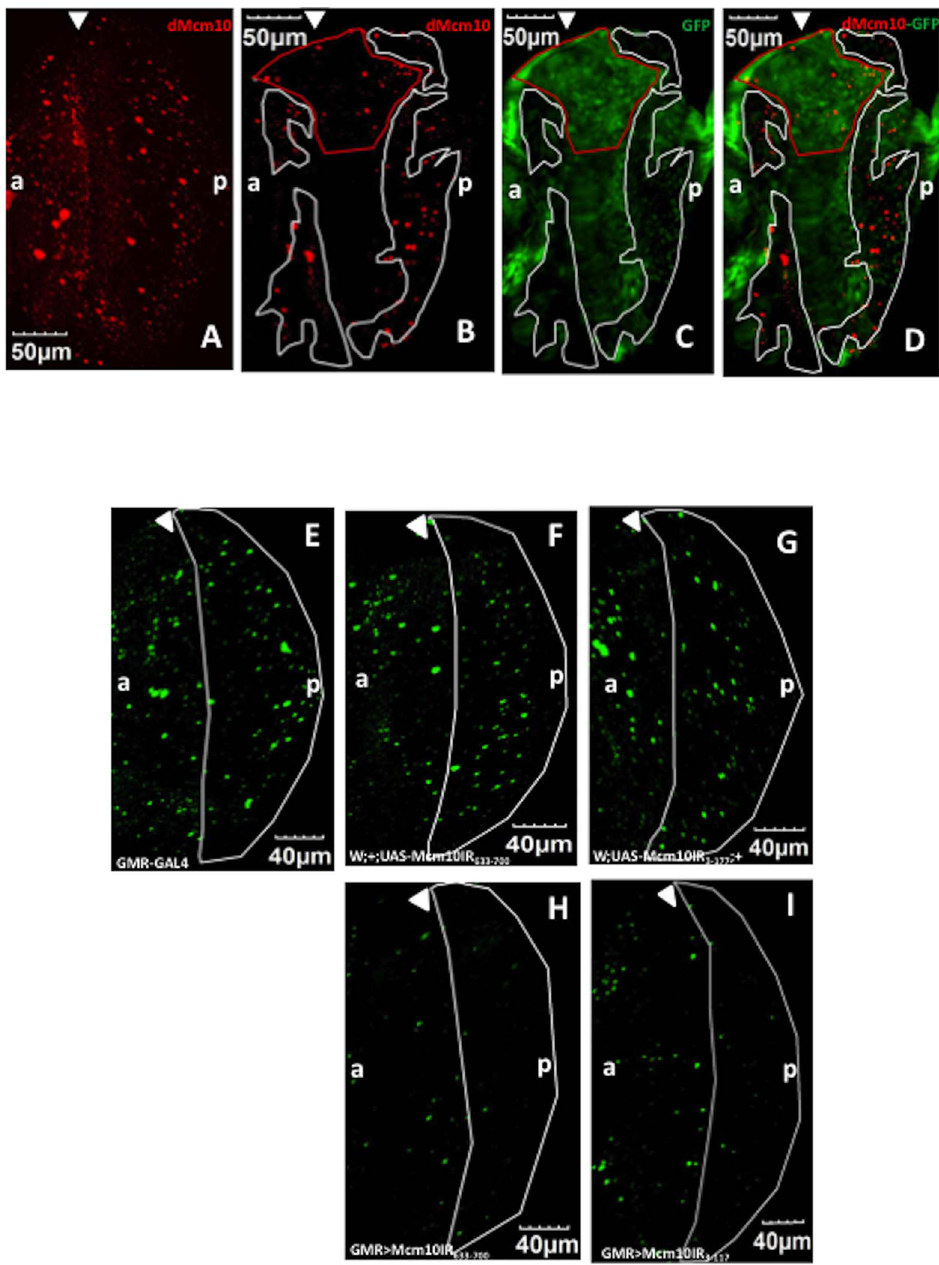
Figure 3. Expression of dMcm10 dsRNA reduces dMcm10 levels in eye discs. In the flip out experiment: (A) Eye imaginal discs of Canton S are stained with anti-dMcm10 antibody (Red). (B) Eye discs expressing dMcm10 dsRNA are stained with anti-dMcm10 antibody (Red). (C) Cells expressing dMcm10 dsRNA are marked with GFP (Green). (D) Merged image of anti-dMcm10 and GFP signals in dMcm10 knockdown eye discs. The white border lines show the GFP-negative region in which dMcm10 dsRNA is not expressed. The red border line shows the region in which the eye disc is folded back and some apparently overlapped signals in this region. In the experiment for dMcm10 knockdown by GMR -GAL4 driver: (E) GMR - GAL4: + : + ; (F) w ; + ; UAS- Mcm10IR 633-700 , (G) w ; UAS- Mcm10IR 3-117 ; + ; (H) GMR -GAL4; + ; UAS- Mcm10IR 633-700 ; (I) GMR -GAL4: UAS -Mcm10IR 3-117 ; + . (E-I) eye imaginal discs are stained with anti-dMcm10 antibody (Green). (E–G) dMcm10 signals are observed everywhere in the eye discs including the posterior regions (white border line). However, in two independent knockdown flies (H and I), there is a significant reduction of dMcm10 signals in the posterior regions. White arrowheads indicate morphogenetic furrow (MF). The bars indicate 50 m m and 40 m m respectively. (a) indicates anterior, (p) indicates posterior. doi:10.1371/journal.pone.0093450.g003 excluded from the nucleolus and DAPI-dense heterochromatic will require more detailed examination of polytene chromosome preparations. In addition, double staining with anti-dMcm10 chromocenter (Figure 1C, F, I, L and O). These results suggest that both proteins mainly localize on euchromatic regions of the antibody and anti-dpol a antibody showed that both dMcm10 and polytene chromosome in nuclei, although clarification of this point dpol a only partially co-localize in polytene nuclei (Figure 1C, F